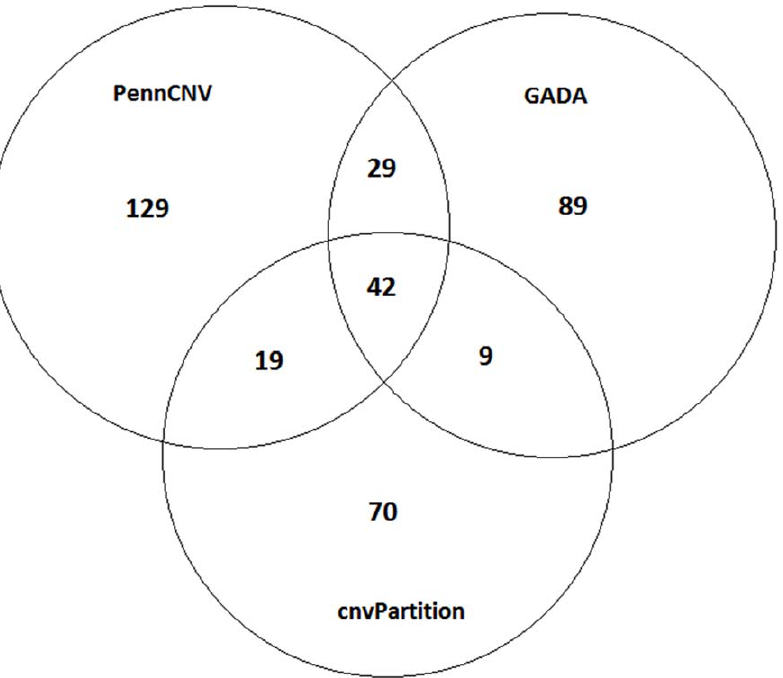
Figure 1. Numbers of CNVs identified by three programs and numbers of CNVs overlapped between different programs.